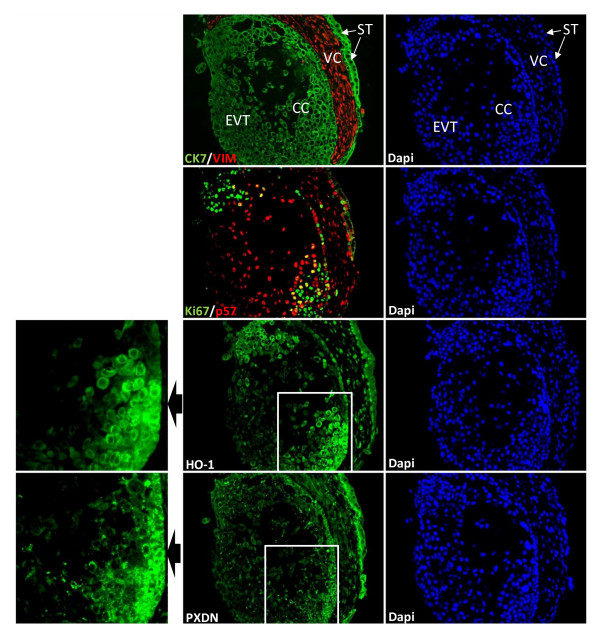
PXDN and HO-1 co-localize in first trimester placenta. Immunohistochemical analyses of serial sections of placental tissues (between 7 and 14th weeks of gestation) stained with different antibodies, counterstained with DAPI and analysed by fluorescence microscopy as described in Materials and Methods. Trophoblast and stromal cells are marked by Cytokeratin 7 (CK7, green) and Vimentin (VIM, red) staining, respectively. Ki67 (red) staining indicates poorly invasive but proliferative EVT, whereas p57 (green) positive cells account for invasive, differentiated EVT. HO-1 and PXDN were stained on separate serial sections. Photographs were taken at 400-fold magnification. VC, villous core; EVT, extravillous trophoblast; CC, cell column; ST, syncytiotrophoblast. Note the relative higher abundance of PXDN and HO-1 in CTB as compared with EVT. Magnification: 200x.